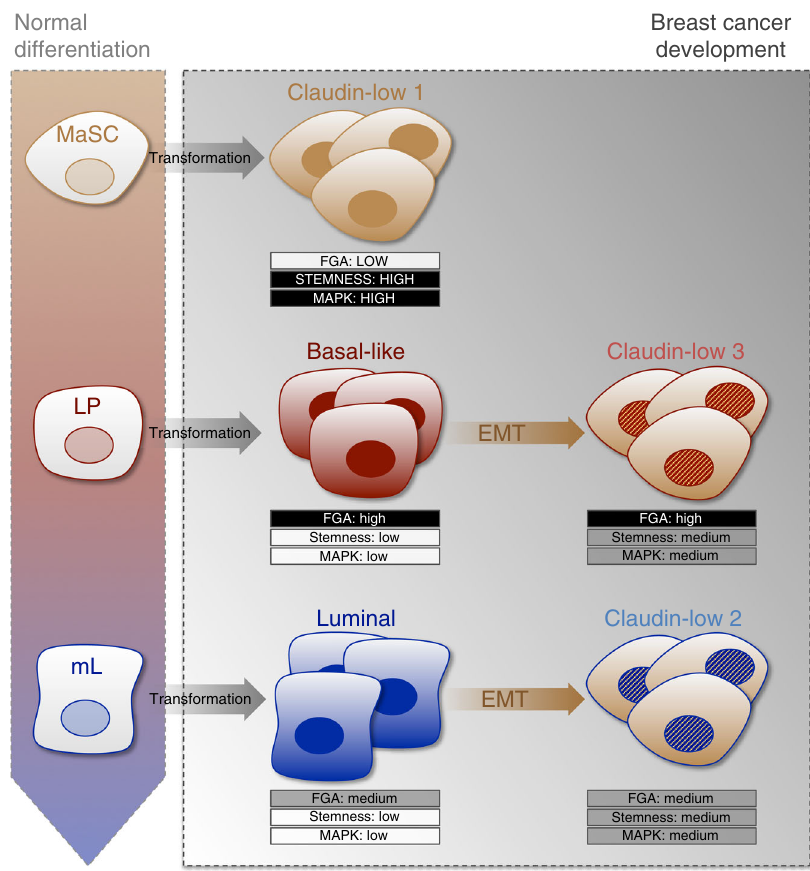
Fig. 7 The diversity of claudin-low tumors re fl ects the impact of the cell-of-origin on the evolutionary process of breast tumorigenesis. The malignant transformation of a normal MaSC leads to undifferentiated tumors with a low genomic instability and a low frequency of TP53 mutations. These features are characteristic of the CL1 subgroup. The activation of an EMT transdifferentiation process and the gain of mesenchymal features in a basal-like tumor promotes the development of a CL3 tumor with extensive genomic aberrations. EMT commitment in a luminal-like breast cancer leads gradually to a CL2 tumor with a moderate level of genomic activation of the RAS-MAPK pathway in claudin-low breast cancers may lead to new therapeutic opportunities that need to be